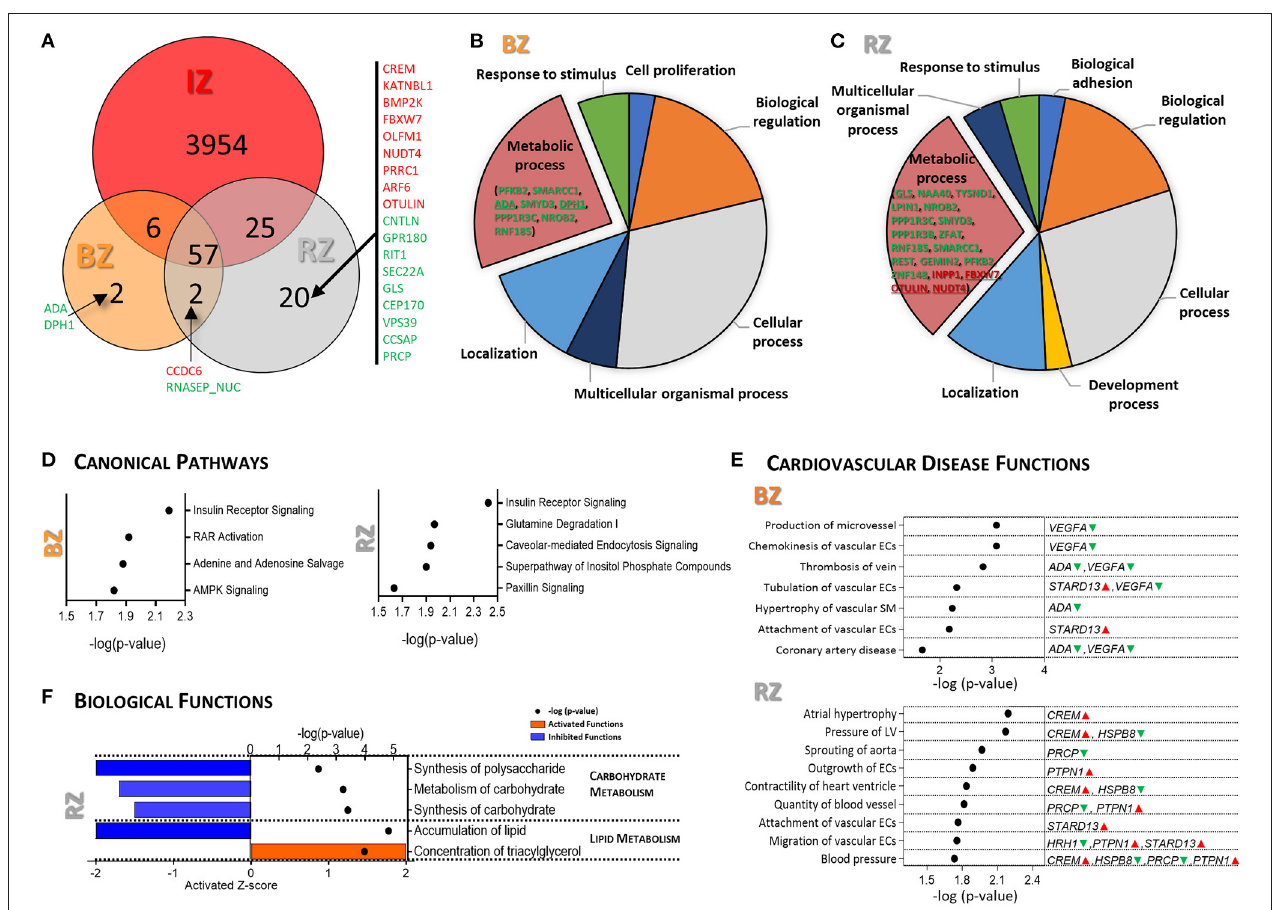
FIGURE 2 | Gene expression analysis of Remote and Border tissue areas of infarcted pig hearts. (A) Venn diagram showing the overlapping DEGs (FC ≥ |1.5| and FDR < 0.05) between IZ, RZ and BZ. Genes marked in red are up-regulated and in green are down-regulated. Pie charts illustrating the results of the PANTHER GO-Slim biological process analysis for the DEGs in BZ (B) and RZ (C) . (D) IPA canonical pathway analysis for the DEGs in BZ (left) and RZ (right). P -value (right-tailed Fisher’s exact test) < 0.05. (E) Representative functional categories related to cardiovascular disease altered in the BZ (upper panel) and in the RZ (lower panel). Full list can be found in Supplementary Table 4 . The genes/metabolites involved in each function are highlighted in green (down-regulated) and red (up-regulated). P -value (right-tailed Fisher’s exact test) < 0.05. (F) IPA biological functions predicted as activated ( Z -score ≥ 1.5, orange) and inhibited ( Z -score ≤ -1.5, blue) in RZ. P -value (right-tailed Fisher’s exact test) < 0.05. No activated/inhibited biological functions were identified in the BZ. IZ/BZ/RZ: n = 6; control n =